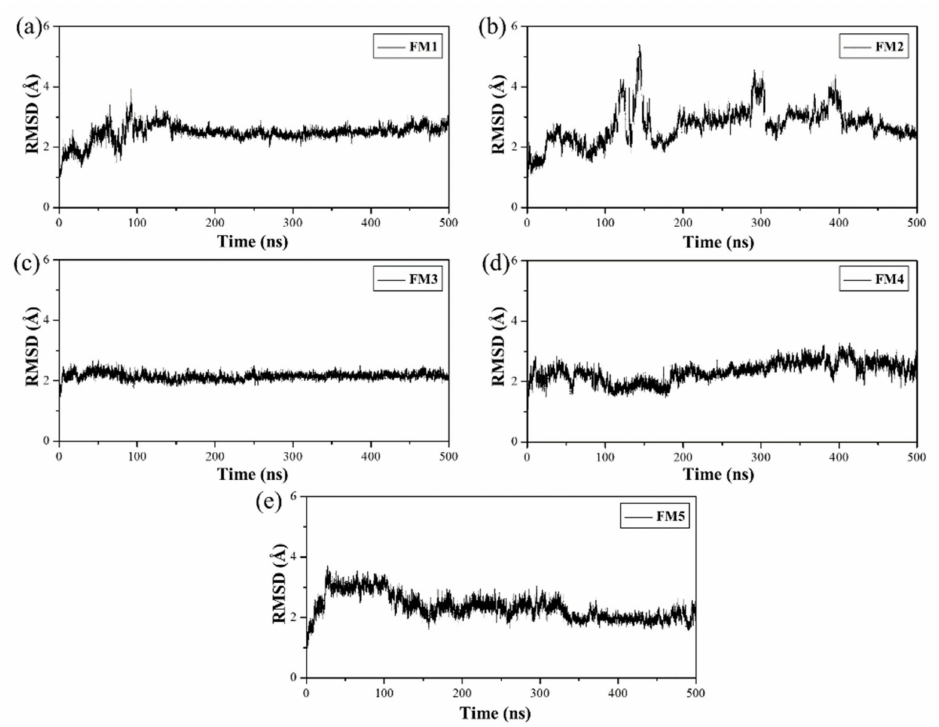
Figure 3. Root mean square deviation (RMSD) values of heavy atoms with respect to the initial structure of the monomer model systems, respectively: ( a ) FM1, ( b ) FM2, ( c ) FM3, ( d ) FM4 and ( e ) FM5.